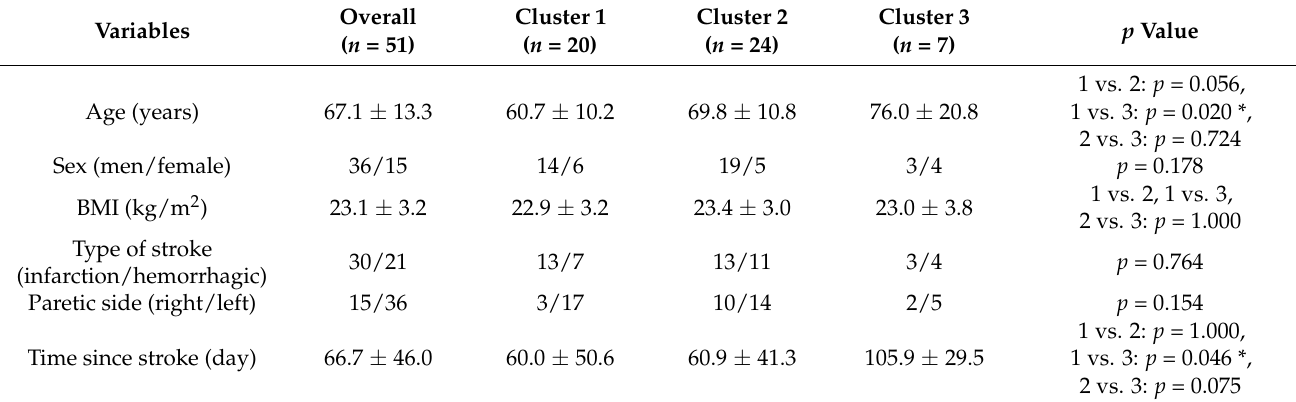
Table 1. Characteristics of overall participants and the three